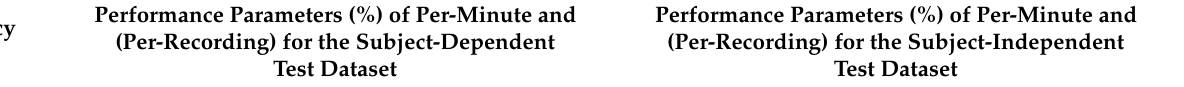
Table 4. Summary results of the per-minute and per-recording analysis using the ECG signals in different subbands for the subject-dependent and subject-independent test